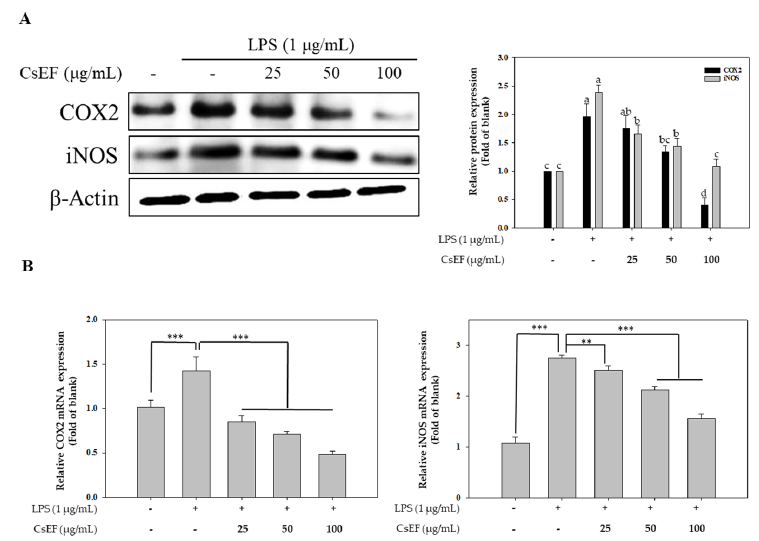
Figure 3. Effect of CsEF on COX2 and iNOS protein expression analysis by Western blotting ( A ) and mRNA translation analysis by RT-PCR ( B ) in LPS treated Raw 264.7 macrophage. Raw 264.7 cells